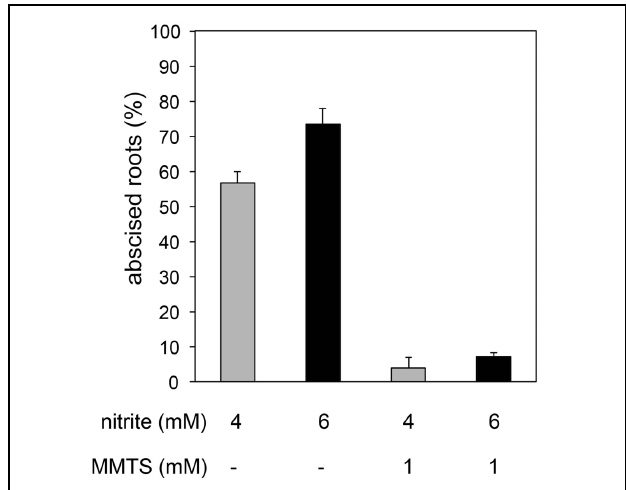
FIGURE 5 | Effect of the thiol-sulfenylating agent methyl methanethiosulfonate (MMTS) on nitrite-induced root abscission. Plants were pre-treated with 1 mM MMTS for 60 min and abscission measured 90 min after addition of nitrite (means ± SE; 4 mM nitrite n = 5, 6 mM nitrite, n = 3).